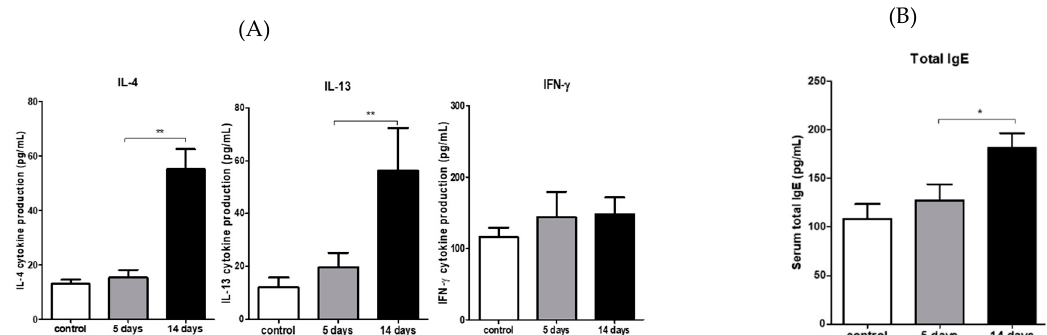
Figure 7. Tra ffi c-related PM 2.5 enhances Th2-mediated allergic responses in the eyes. ( A ) Draining cervical lymph nodes were harvested after the euthanasia of mice on Day 14 (n = four mice per group). Purified T cells with a magnetic bead sorting were stimulated with OVA-pulsed bone marrow dendritic cells for 48 h and then re-stimulated with phorbol myristate acetate / ionomycin for up to 4 h. Cytokines in culture supernatants were quantified by ELISA. ( B ) Exposure to PM 2.5 contributed to increased total IgE in the serum. Blood was collected from mice after 14 days of topical challenge with PM 2.5 or the vehicle. Sera were isolated and measured for total IgE. Data are presented from three to four independent experiments as the mean ± SEM. * p < 0.05. ** p <